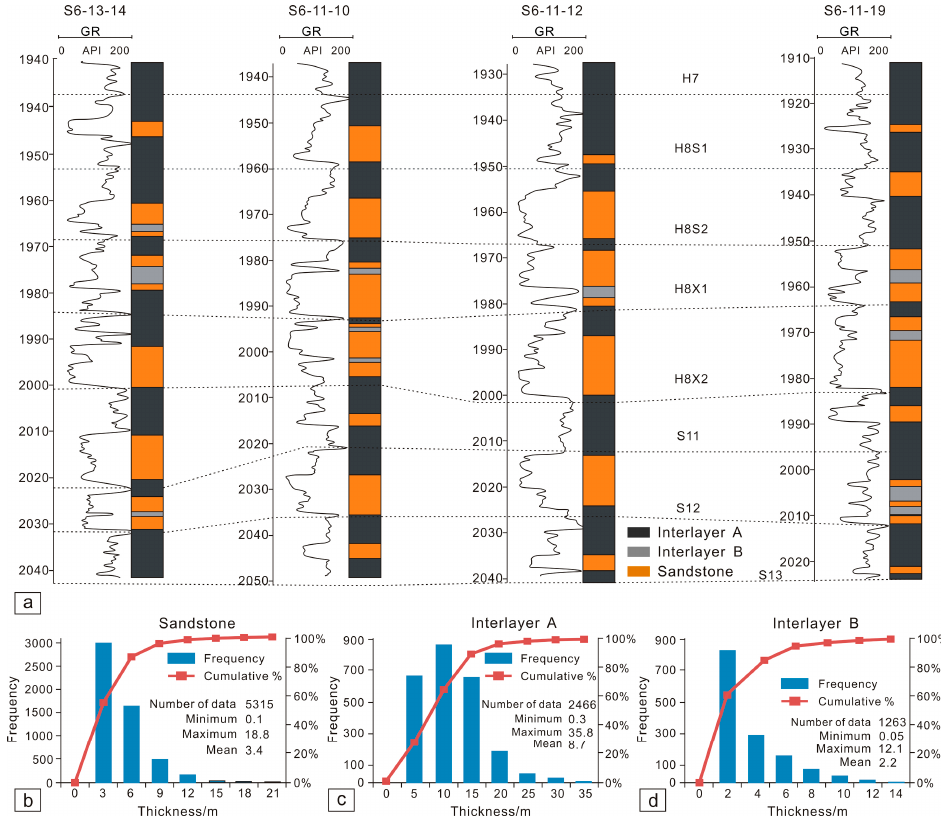
Figure 3. ( a ) 1-D interpreted sandstone and mudstone data of four directional wells; ( b – d ) Statistical histograms of sandstone, interlayer A, and interlayer B, respectively. Note that the mean thicknesses of interlayer A and interlayer B are quite different.